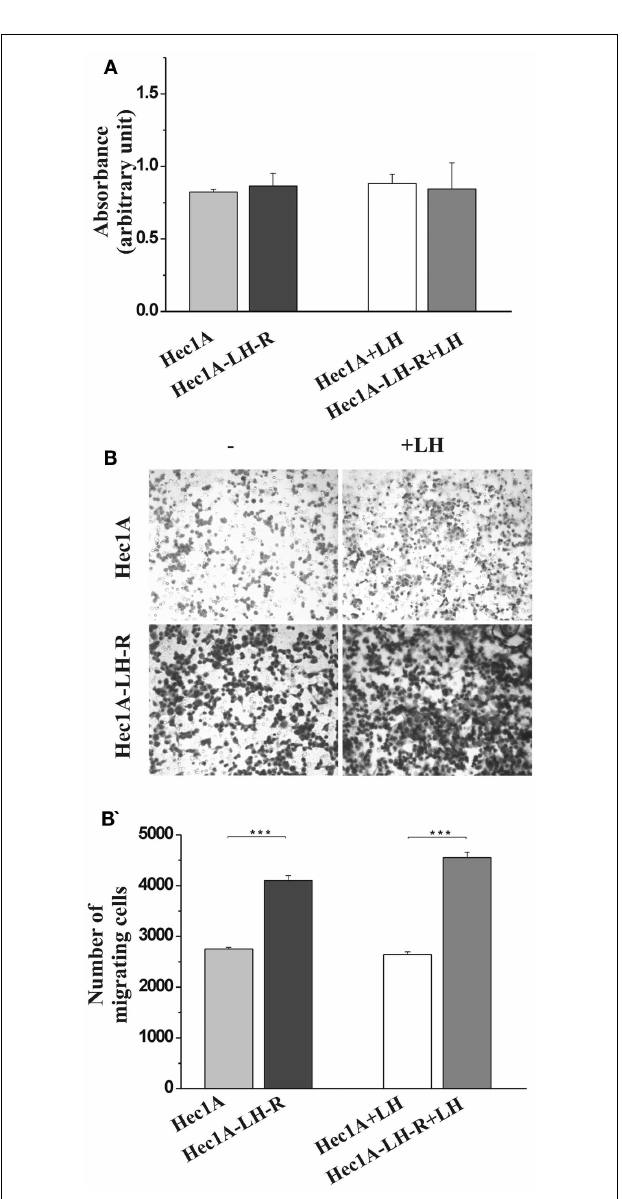
FIGURE 1 | Characterization of cell line over-expressing LH-R in vitro and in vivo : cell proliferation and invasion . (A) Cell proliferation of Hec1A and Hec1A-LH-R cells. Cells (2.5 × 10 4 cells/100 µ l) were cultured in 96-well plates. After 24h incubation, cell proliferation was evaluated with the colorimetricWST-1 assay (the absorbance value is reported on y axes). Histograms represent the mean of the absorbance value ± SEM (error bars). Statistical analysis was performed with Student’s t test. (B,B (cid:48) ) Cell invasion of Hec1A and Hec1A-LH-R cells. Cell invasion was evaluated using a Boyden chamber system where a Matrigel-coated porous membrane (8 µ m pore diameter) was inserted as described in Section “Materials and Methods.” At time 0, recombinant LH was added or not to the medium.The number of migrated cells was determined after 24h of incubation. Cells were fixed and stained with Diff–Quick staining solution, and counted on the whole migration field at × 40 magnification. In (B) pictures relative to representative membrane for Hec1A and Hec1A-LH-R cells, in the presence or in the absence of LH, are reported. Histograms in (B (cid:48) ) represent the mean of migrated cells ± SEM (error bars). Statistical analysis was performed with Student’s t